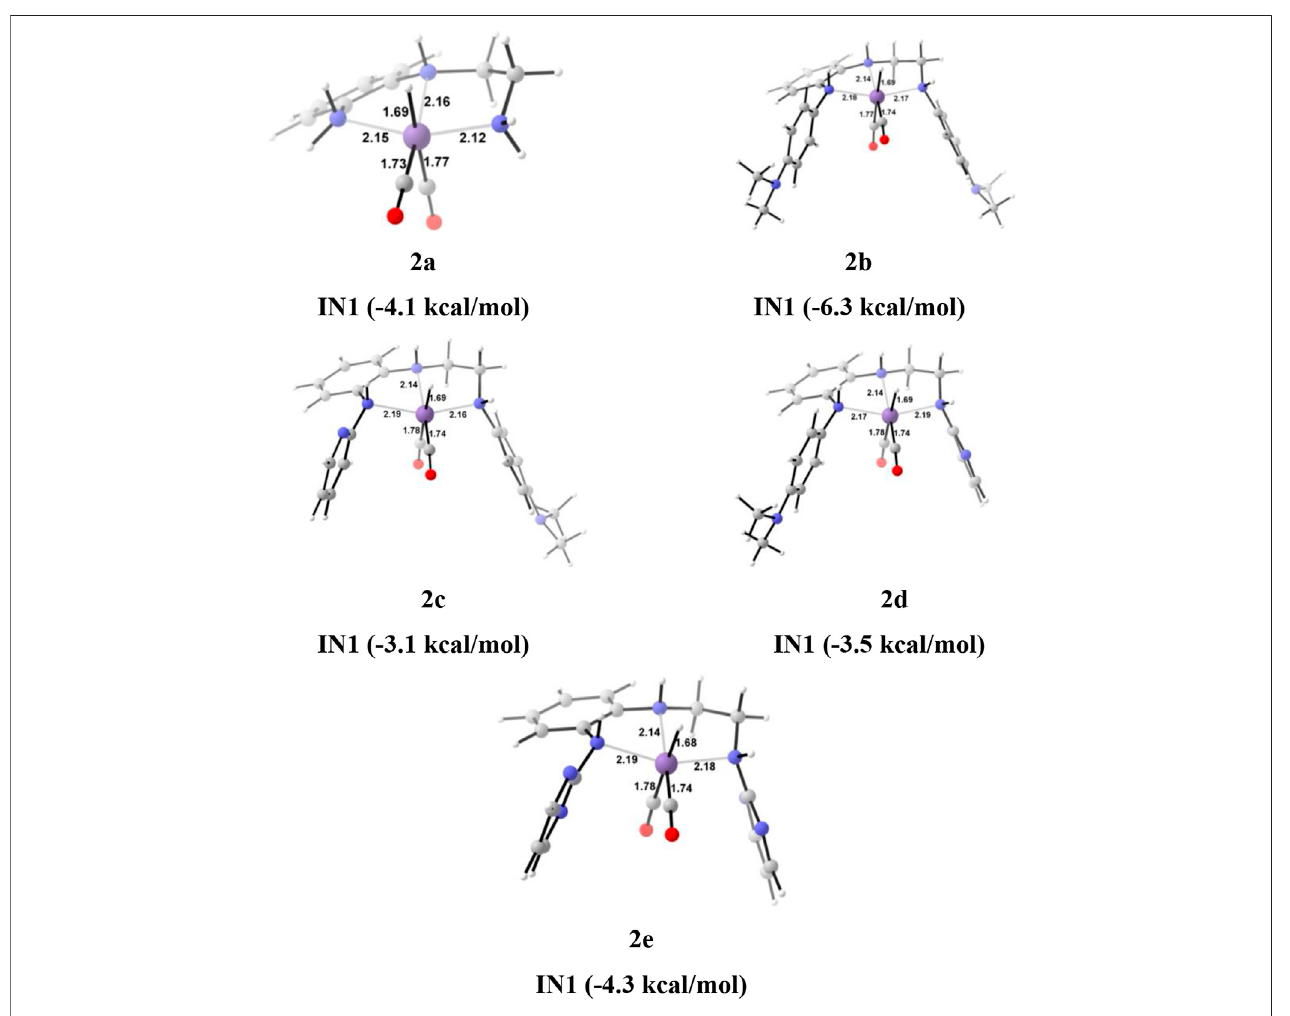
FIGURE 7 | The optimized geometries of the Group 2IN1 catalysts. The bond lengths are in Å, and relative Gibbs free energies are in parentheses (The optimized geometries of all the transition states and intermediates are disclosed in Supplementary Data Sheet S1 ).